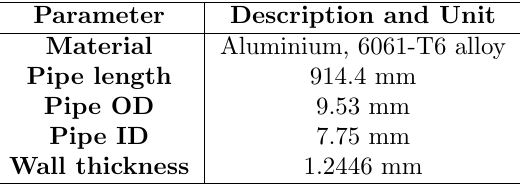
Table 1: Drill pipe